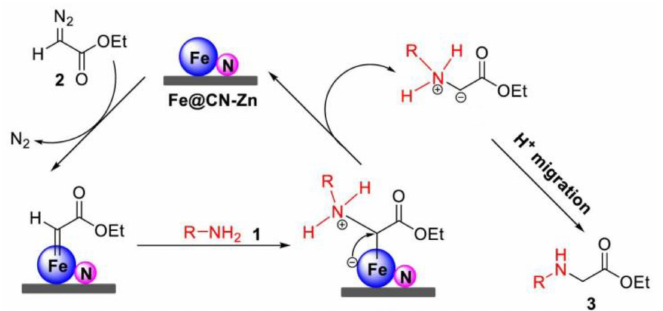
Figure 19. Mechanism of N-H carbene insertion reaction catalyzed by Fe@CN-Zn. Reprinted with permission from Ref. [50]. Copyright 2021,